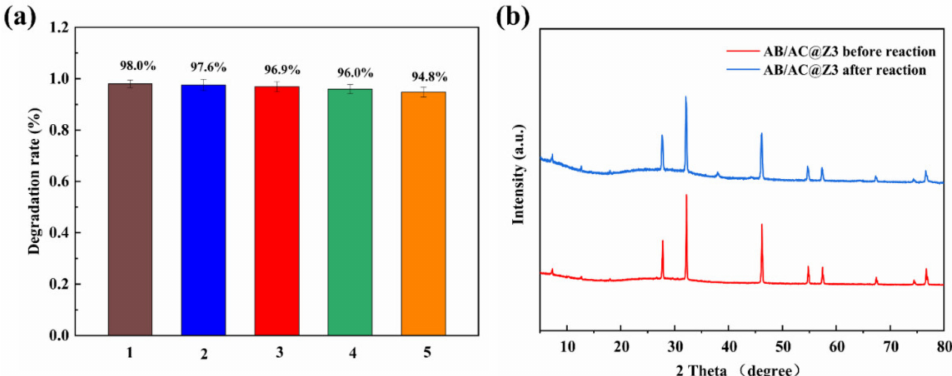
Figure 9. ( a ) Cyclic experiment of degradation of RhB solution. ( b ) XRD patterns of catalyst after recycling experiments.